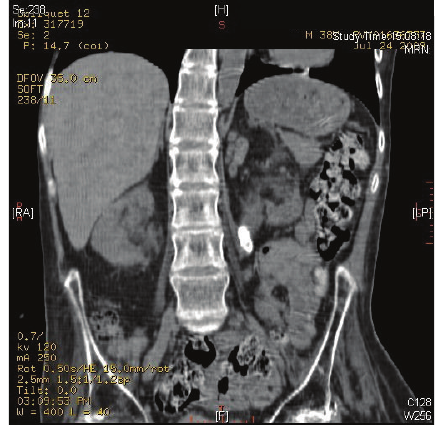
Figure 3: CT of urinary tract, performed on 24 July 2009, revealed twocmlengthcalculusinleftureteratthelevelofL-3/4causingmild hydronephrosis.